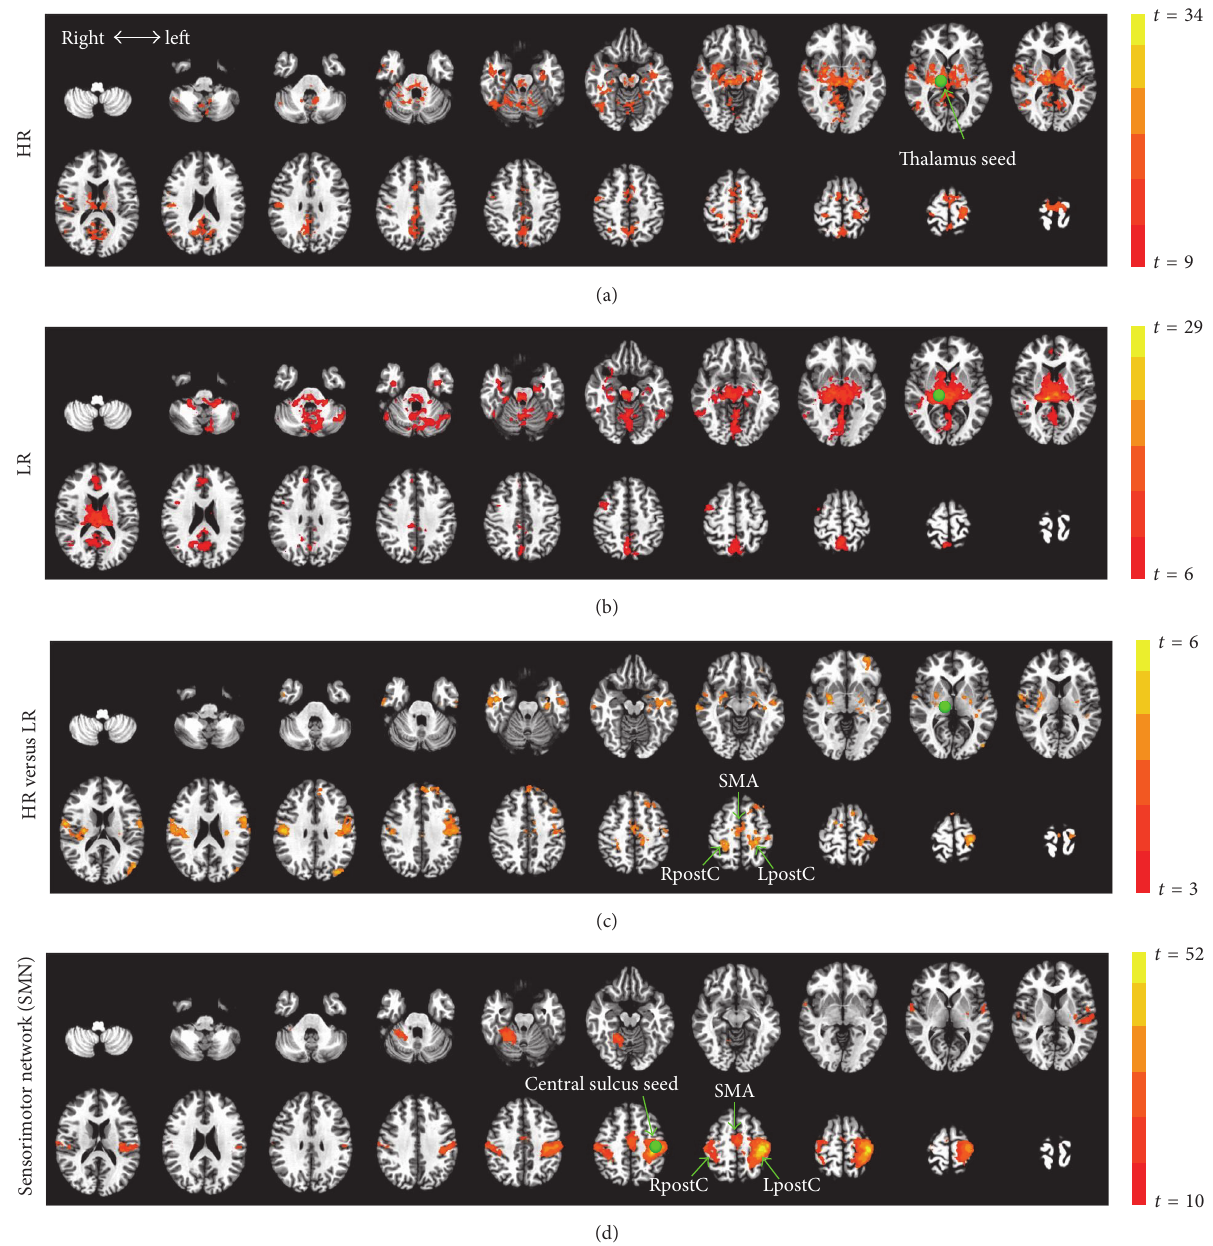
Figure 2: Seed-based functional connectivity (FC). (a) Thalamus-seed FC map for high-ranked (HR) swimmers is shown by a one-sample 𝑡 -test (against zero) with a threshold of top 10% voxels of the whole brain ( 𝑝 = 1.6𝑒 − 7 ). (b) Thalamus-seed FC map for low-ranked (LR) swimmers (top 10% voxels; 𝑝 = 3.2𝑒−5 ). (c) Contrastmap for HR versus LR by a two-sample 𝑡 -test( 𝑝 < 0.05 , corrected). (d) The sensorimotor network (SMN), including the supplementary motor area (SMA) and both the right postcentral gyrus (RpostC) and left postcentral gyrus (LpostC), is identified by left central sulcus-seed FC (top 5% voxels; 𝑝 = 8.0𝑒 − 14 ) in the entire group ( 𝑛 = 30